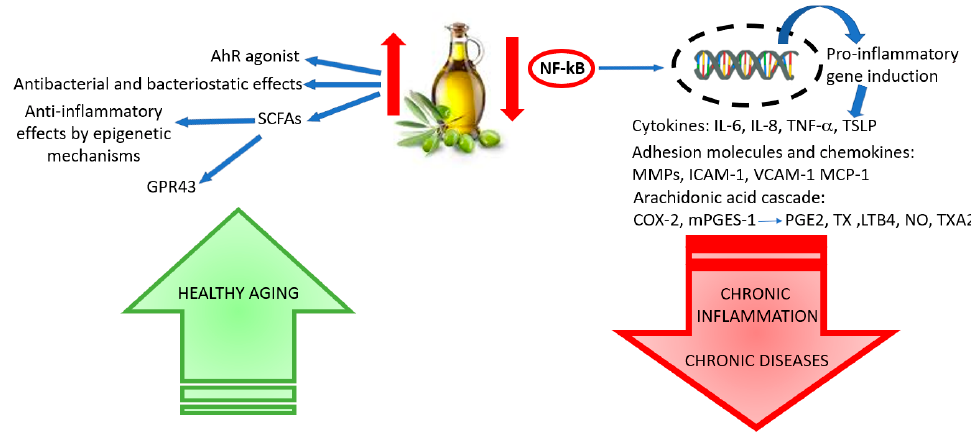
Figure 3. EVOO polyphenols in inflammation inhibition and their healthy effects in aging.